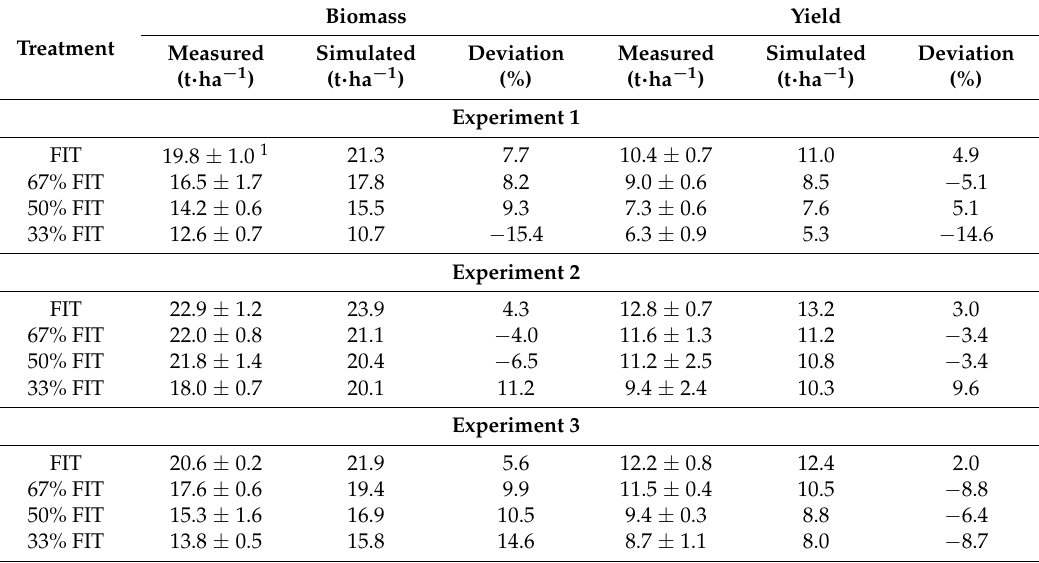
Table 5. Simulated compared with measured values of aboveground biomass and grain yield at harvest for the different irrigation treatments for the three cropping seasons.